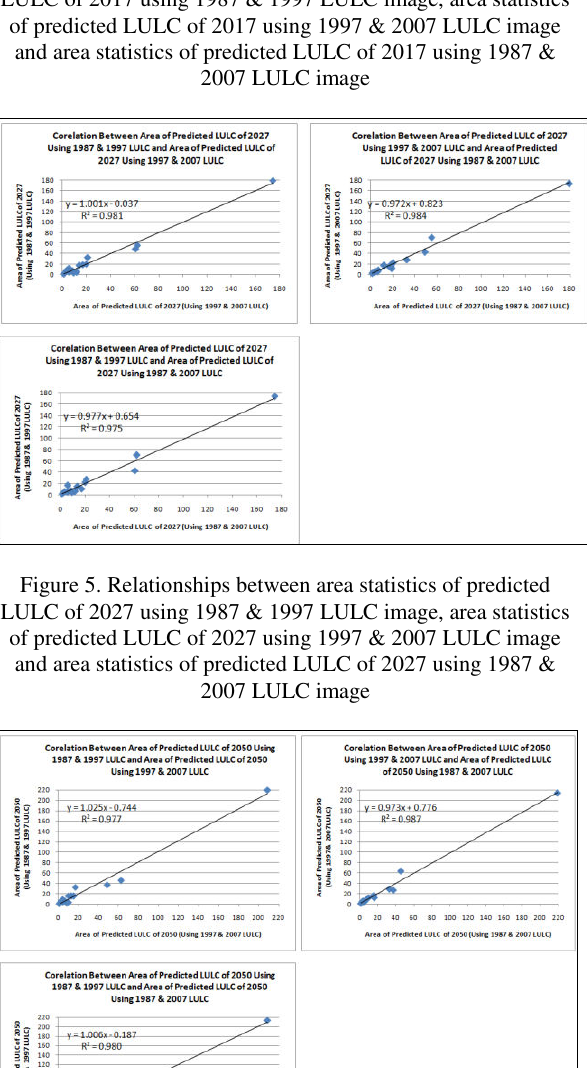
Figure 8. Predicted LULC of 2027 using 1987 & 1997 LULC image, using 1997 & 2007 LULC image and using 1987 & 2007 LULC Figure 6. Relationships between area statistics of predicted LULC of 2050 using 1987 & 1997 LULC image, area statistics of predicted LULC of 2050 using 1997 & 2007 LULC image and area statistics of predicted LULC of 2050 using 1987 & 2007 LULC image